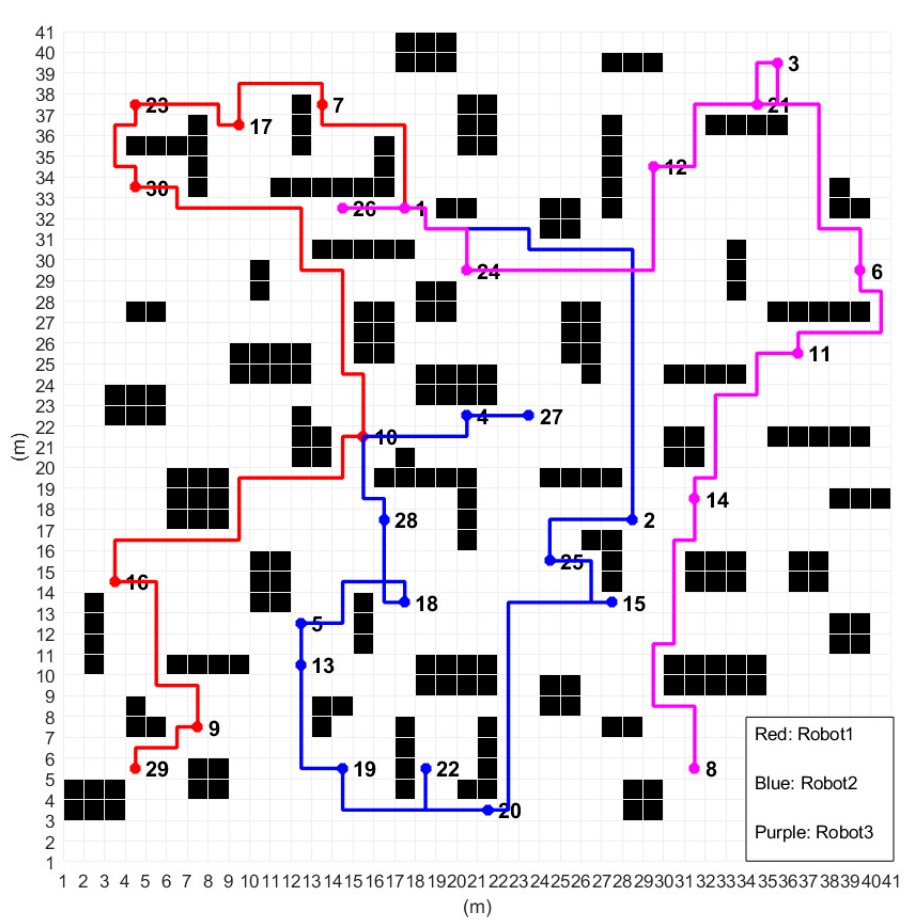
Figure 16. A* algorithm path planning diagram of the initial task sequence from Experiment 5.